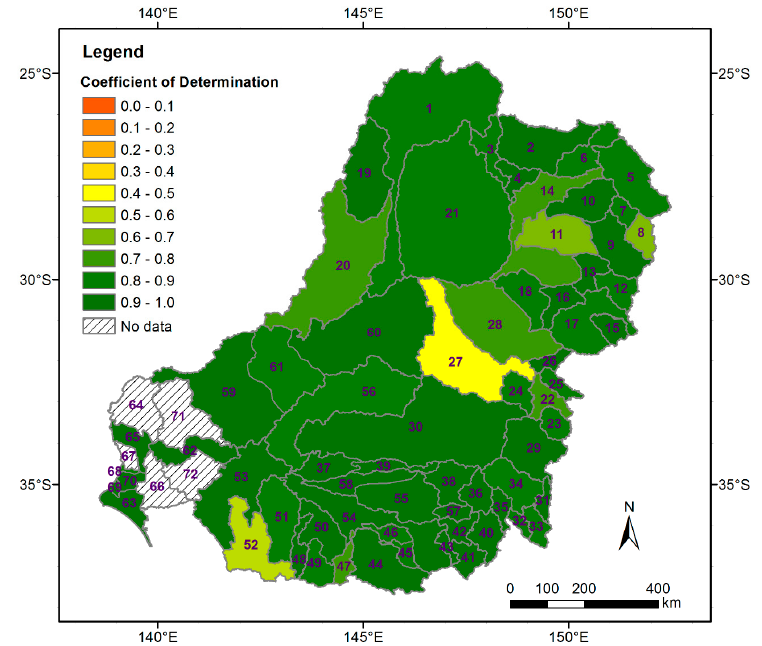
Figure 9. Coefficient of determination (R 2 ) for the relationship between flow peaks and y in Equation